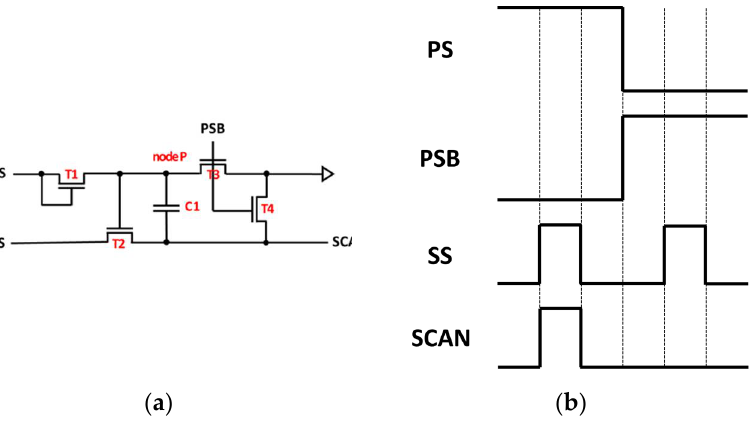
Figure 1. The unit stage ( a ) and timing chart ( b ) of the proposed scan driver.